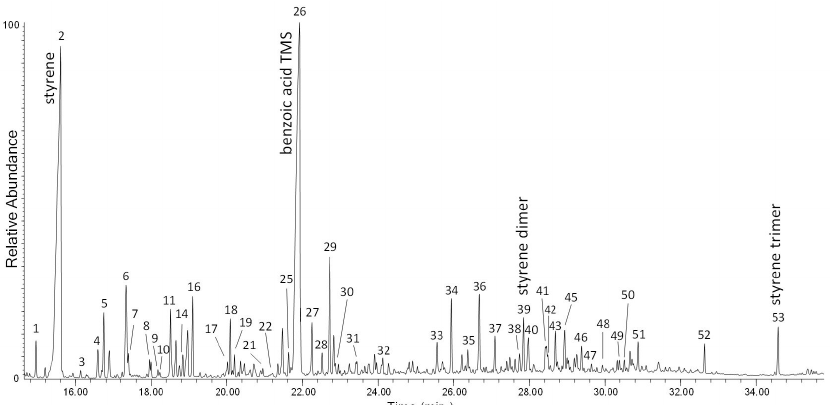
Figure 11. Chromatogram obtained in the Py(HMDS)–GC–MS analysis of the MeOH extract of PS-4w. Peak identification is reported in Table